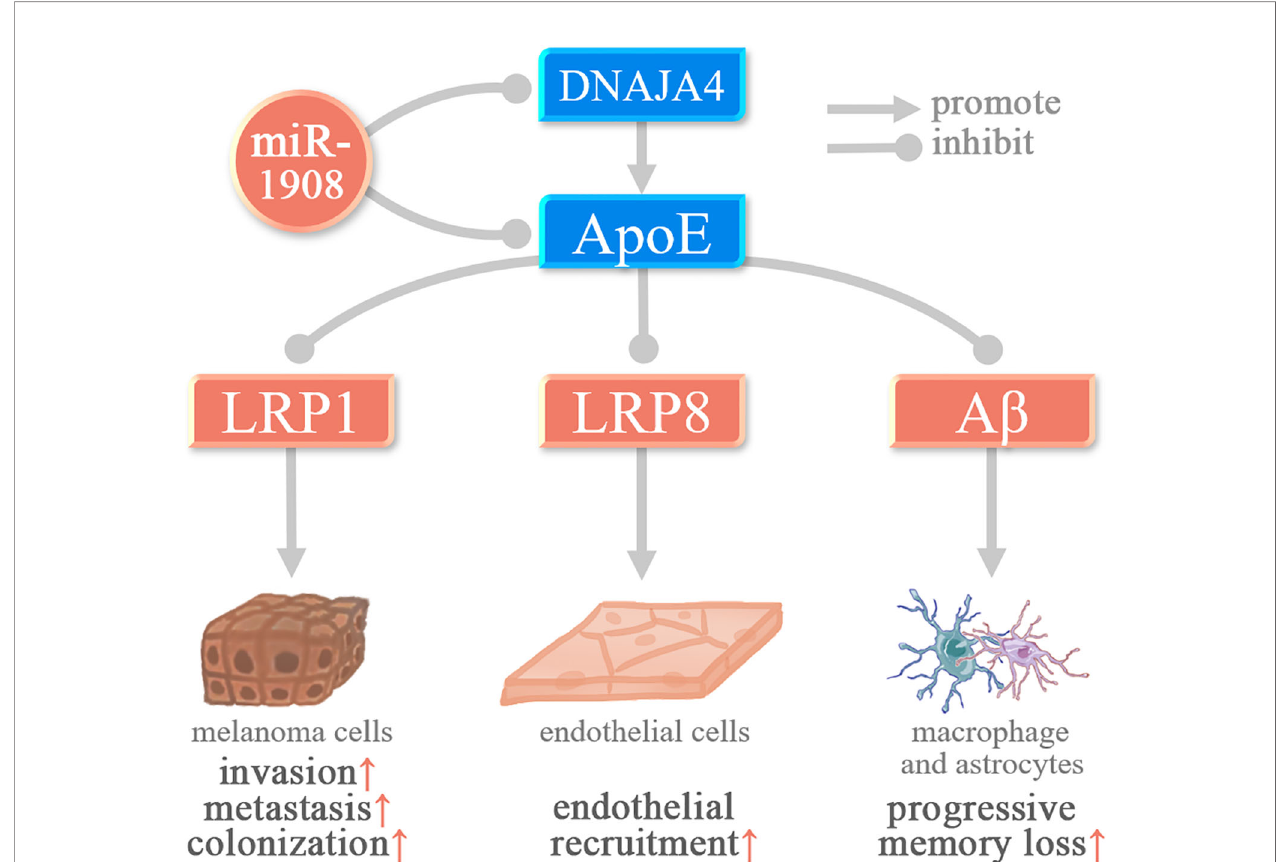
FIGURE 3 | miR-1908-5p plays a role in melanoma and Alzheimer ’ s disease by targeting